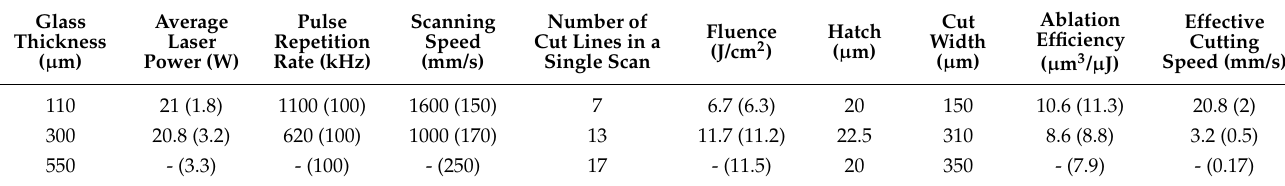
Table 1. Glass cutting parameters and performance for fs cutting in ambient air. Values presented outside brackets represent cutting at high laser power (P max ), while values inside brackets represent cutting at low laser power (P min ). Cutting width, hatch, and the number of cut lines were maintained the same for both high- and low-power cutting.